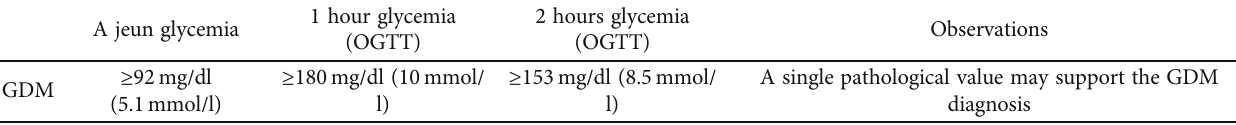
Table 1: Diagnosis criteria for GDM (OGTT with 75 g